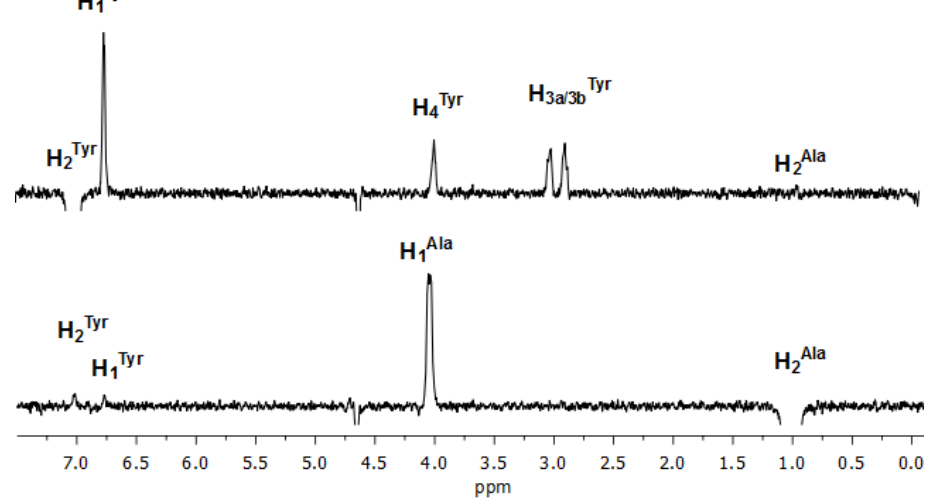
Figure 4. One-dimensional (1D) Rotating-frame Overhauser Effect SpectroscopY (ROESY) spectra (600 MHz, D 2 O, 25 °C) of H 2Tyr and H 2Ala of DAL (9.8 mM).